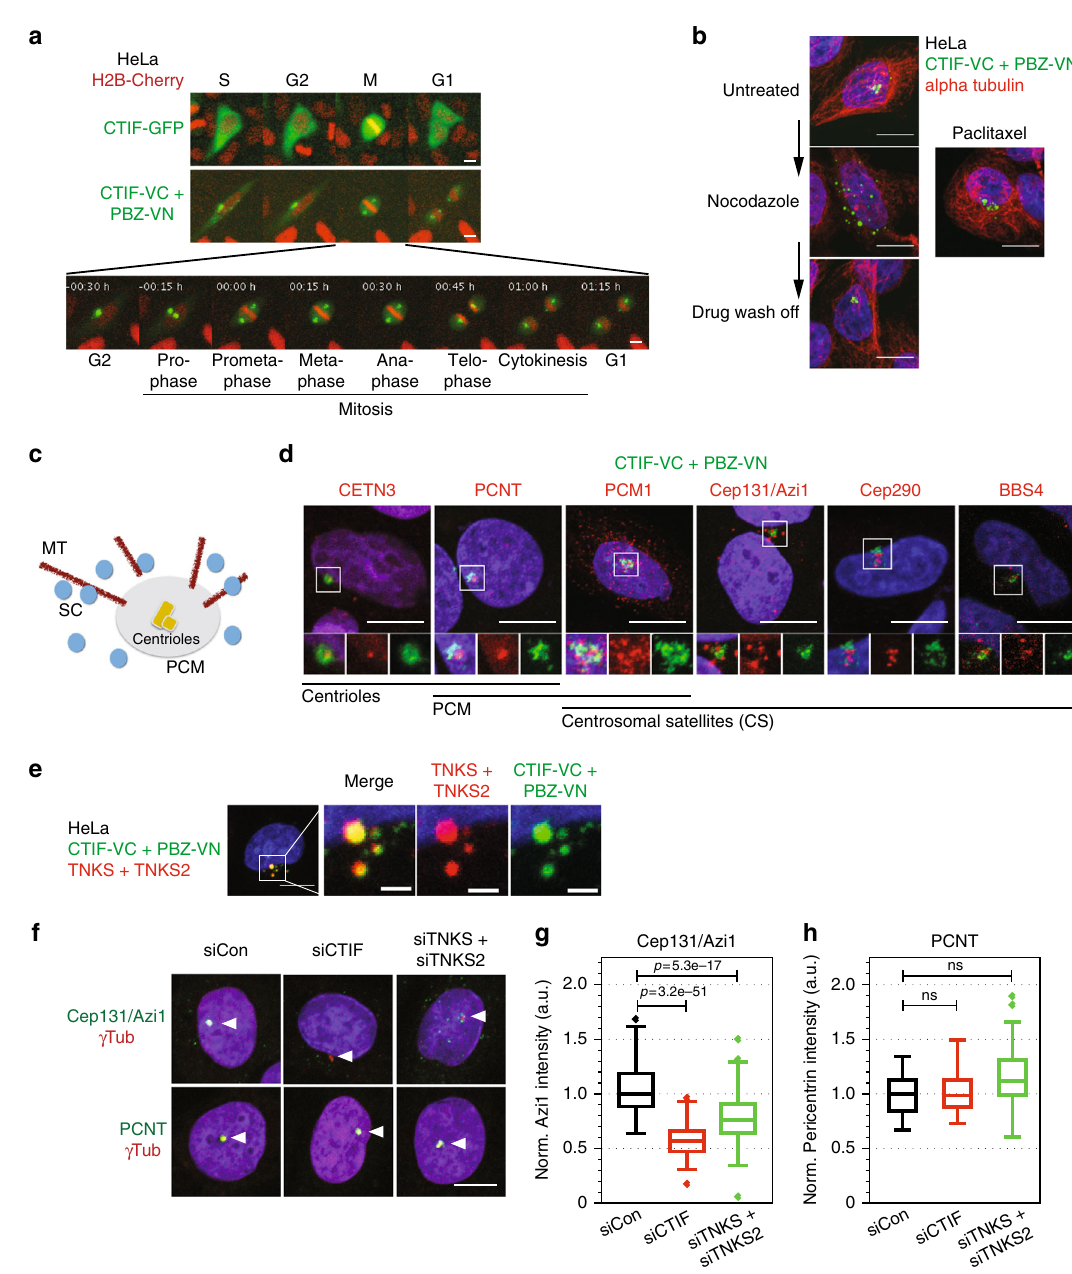
Fig. 5 CTIF modulates centrosomal satellites. a CTIF biosensor localizes and segregates with the centrosome. Live cell imaging of H2B-cherry HeLa cells expressing either CTIF-GFP or CTIF-VC + PBZ-VN showed that CTIF-GFP is distributed throughout the cytoplasm during M phase (top images), while CTIF-VC + PBZ-VN signal (lower images) segregated with the centrosome during mitosis. Detailed time series are shown in Supplementary Fig. 5a. b CTIF biosensor localization is microtubule-dependent. HeLa cells expressing CTIF-VC + PBZ-VN were exposed to either nocodazole or paclitaxel. Nocodazole caused a reversible dispersal of the signal while the microtubule-stabilizing drug paclitaxel did not. c Schematic illustrating the centrosome with a central pair of centrioles, surrounded by pericentrosomal material (PCM), microtubules (MT) and centrosomal satellites (CS). d Co-localization of CTIF biosensor and various centrosomal markers showed that PARylated CTIF is peripheral to inner centrosomal markers (CETN3 and PCNT) and PCM (PCNT and PCM1), while it is localized in the area occupied by the centrosomal satellites (Cep131/Azi1, Cep290 and BBS4); insets are with 2 µ m sides. e CTIF PARylation biosensor co-localizes with tankyrase. HeLa cells transfected with CTIF-VC + PBZ-VN were immunostained for endogenous tankyrase; scale bars in the zoomed images represent 1 μ m. f CTIF depletion affects the centrosomal satellites, but not the core centrosome. HeLa cells were depleted by CTIF or tankyrase ( TNKS + TNKS2 ) siRNA and immunostained for various centrosomal markers. Images show staining for the centrosomal satellite marker Cep131/Azi1 and for the core centrosome marker PCNT together with centrosomal marker γ Tubulin. Images for all the other analyzed markers are shown in Supplementary Fig. 5b and full summary is provided in Table 2. The average intensity of the signal at the centrosomal area was quanti fi ed in n = 150 nuclei and normalized to the median of the mock-transfected cells. Box plot shows that CTIF depletion, and to a lower extend tankyrase depletion, leads to the dispersal of the centrosomal satellite (Cep131/Azi1 quanti fi ed in g ), while not affecting the core centrosome (PCNT quanti fi ed in h ); box plot shows quartiles, p -values were calculated by two-sided Student ’ s t -test. Scale bars represent 5 µ